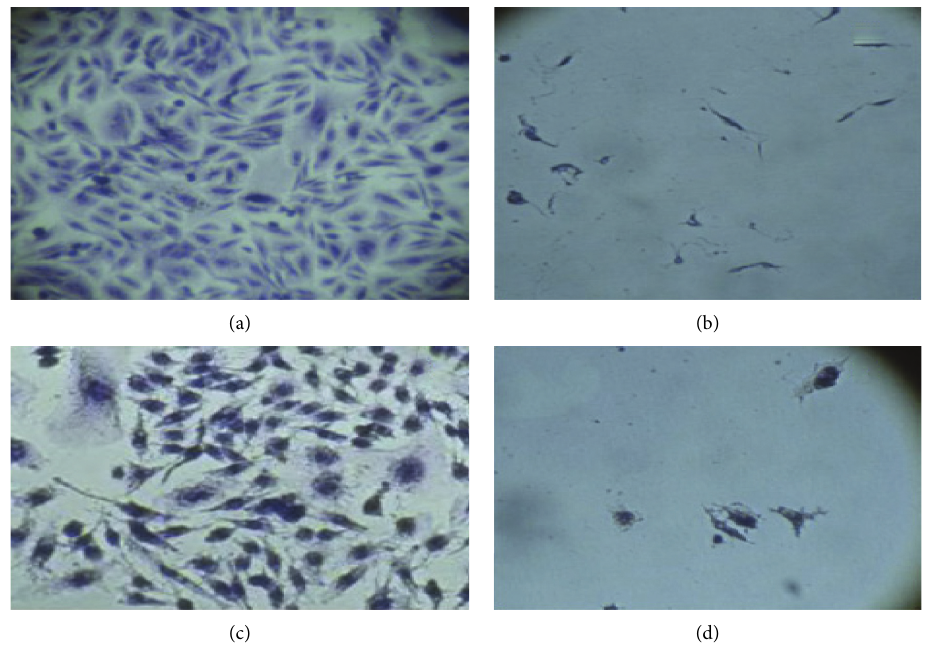
Figure 4: Cytotoxicity assay on CHO cell line. (a) CHO cell control. (b) Positive control with V. cholerae O1 serotype Ogawa filtrate. (c) Cytopathic effect caused by V. mimicus filtrates after three hours of exposure. (d) Destruction of the cell monolayer caused by the V. mimicus filtrates after six hours of exposure (inverted microscope 40X).